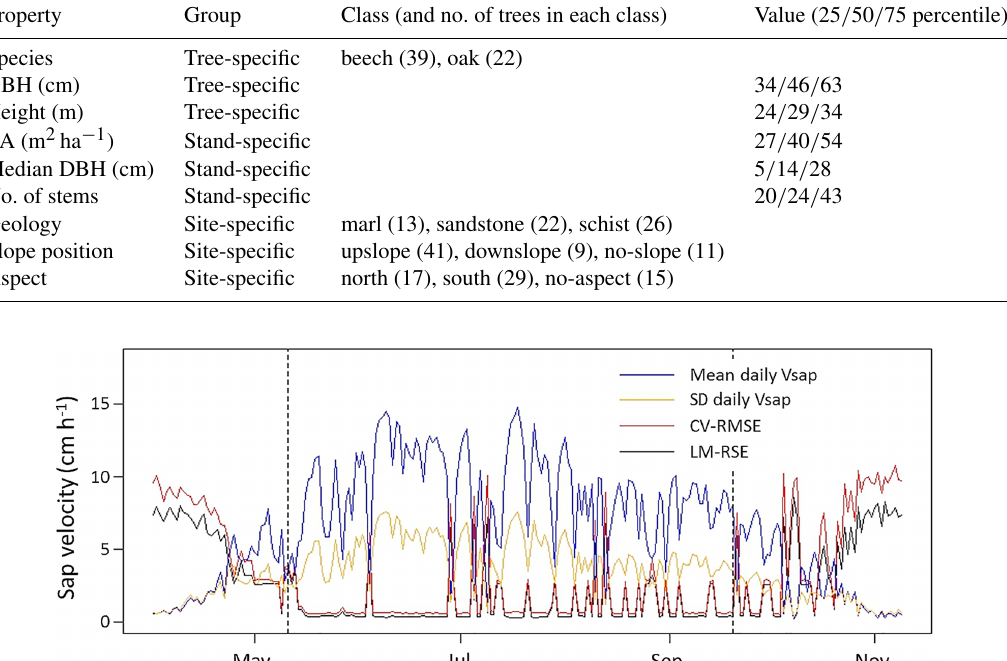
Table 1. Overview of the characteristics associated with the trees in the sap velocity dataset. These are used as predictors in the multiple linear regression. Abbreviations are DBH for diameter at breast height, BA for basal area of the stand.